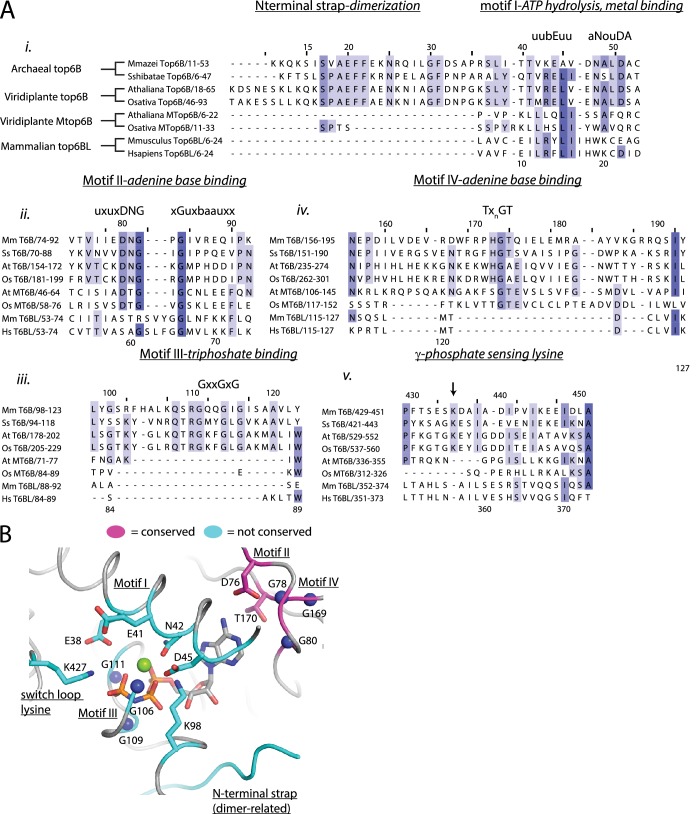
Conservation of canonical GHKL elements between Top6B, MTop6B, and Top6BL.(A) Alignment of archaeal Top6B (M. mazei, S. shibatae), Viridiplante Top6B (A. thaliana, O. sativa), Viridiplante Mtop6B (A. thaliana, O. sativa), and mammalian Top6BL (Mus musculus, Homo sapiens) comparing motifs important for ATP hydrolysis. These include (i) the N-terminal dimerization strap and motif I, metal binding and ATP hydrolysis; (ii) motif II, adenine binding and base discrimination; (iii) motif III, triphosphate binding; (iv) motif IV, adenine binding and (v)transducer domain γ-phosphate sensor loop (Dutta and Inouye, 2000; Schoeffler and Berger, 2008; Thomsen and Berger, 2008). Numbering above the alignment corresponds to M. mazei Top6B, numbering below the alignments corresponds to H. sapiens Top6BL. (B) Ribbon representation of the ATP binding pocket of S. shibatae Top6B bound to AMPPNP (PDB ID = 1M × 0 [Corbett and Berger, 2003]) with the sidechains of residues involved in hydrolysis (E38), metal binding (N42), triphosphate binding (G106, G109, G111, K98), adenine binding (D76, T170, G78, G80, G168), phosphate sensing (K427), or binding pocket integrity (E41, D45) shown as sticks. Nitrogen atoms of denoted main chain glycine residues are shown as blue spheres. Residues generally conserved in the meiotic Top6B homologs are shown in magenta and poorly conserved residues are shown in cyan. Motifs I-IV and the switch lysine residue are labeled. Residues are numbered according to S. shibatae Top6B.